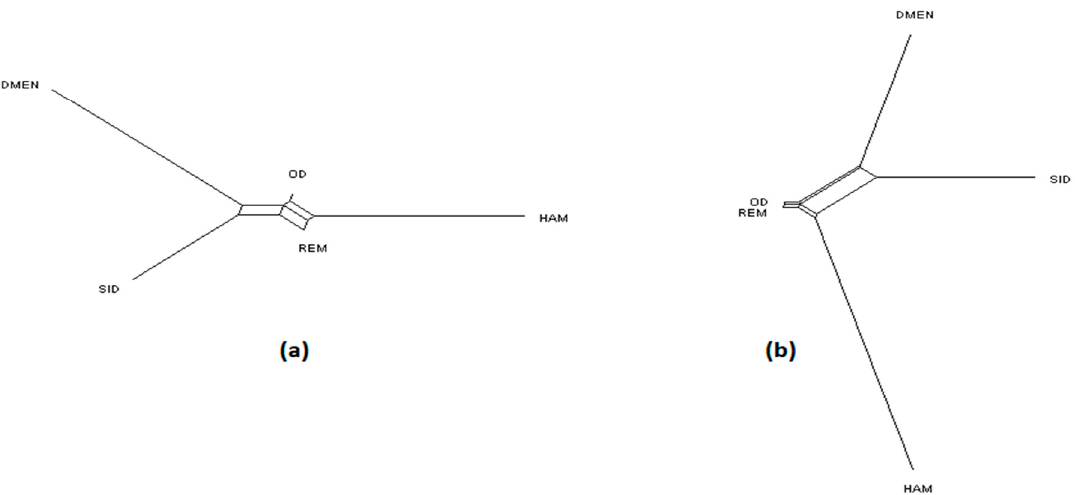
Figure 1. NeighborNet graph considering Algerian sheep breeds, from a matrix of Reynolds’ distances. ( a ) Plot obtained from the microsatellite dataset; ( b ) plot obtained from the single nucleotide polymorphism (SNP) dataset. For breed names see codes in Table S1.